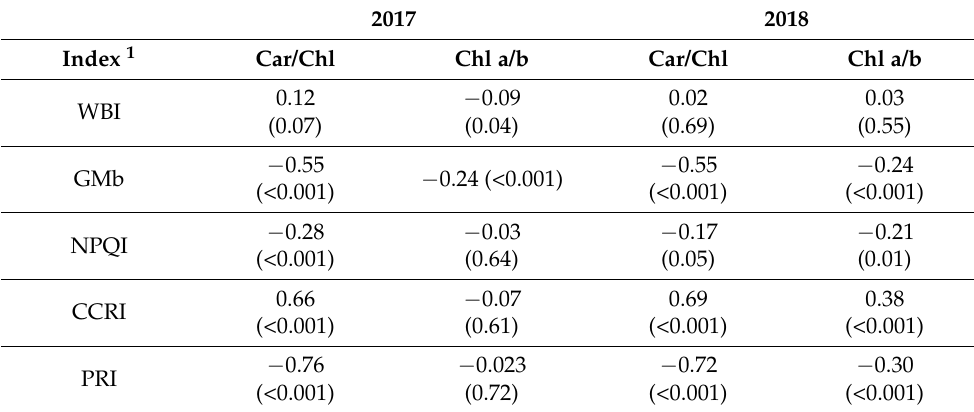
Table 4. Initial correlation results for all hyperspectral indices versus pigment ratios. (Correlation Coefficient (r) and